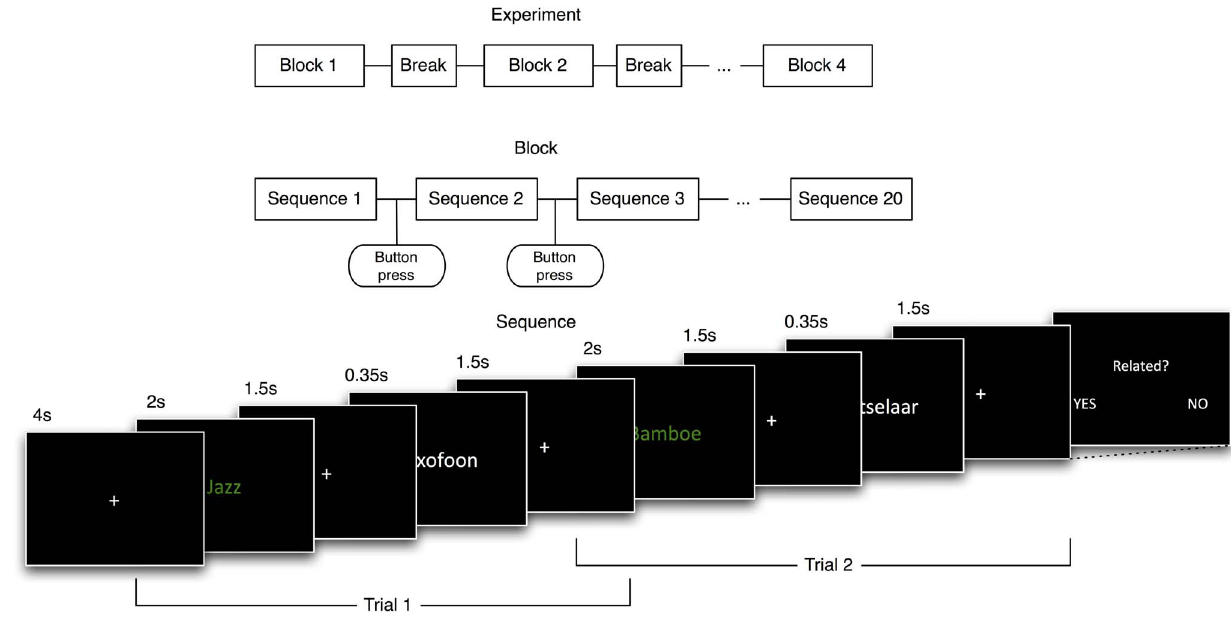
Figure 2. Schematic overview the experimental design. From global in time (top), to local in time (bottom).